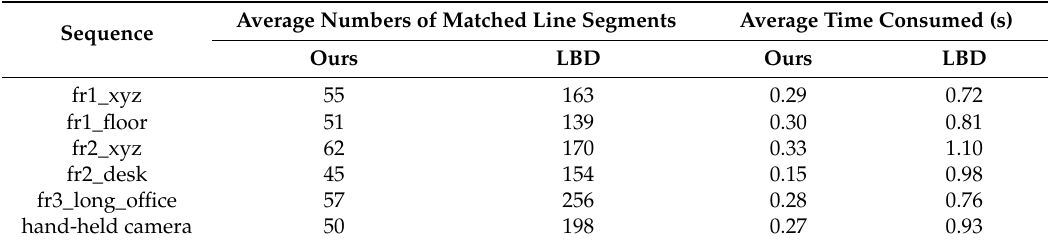
Table 1. Comparison of our algorithm and the LBD